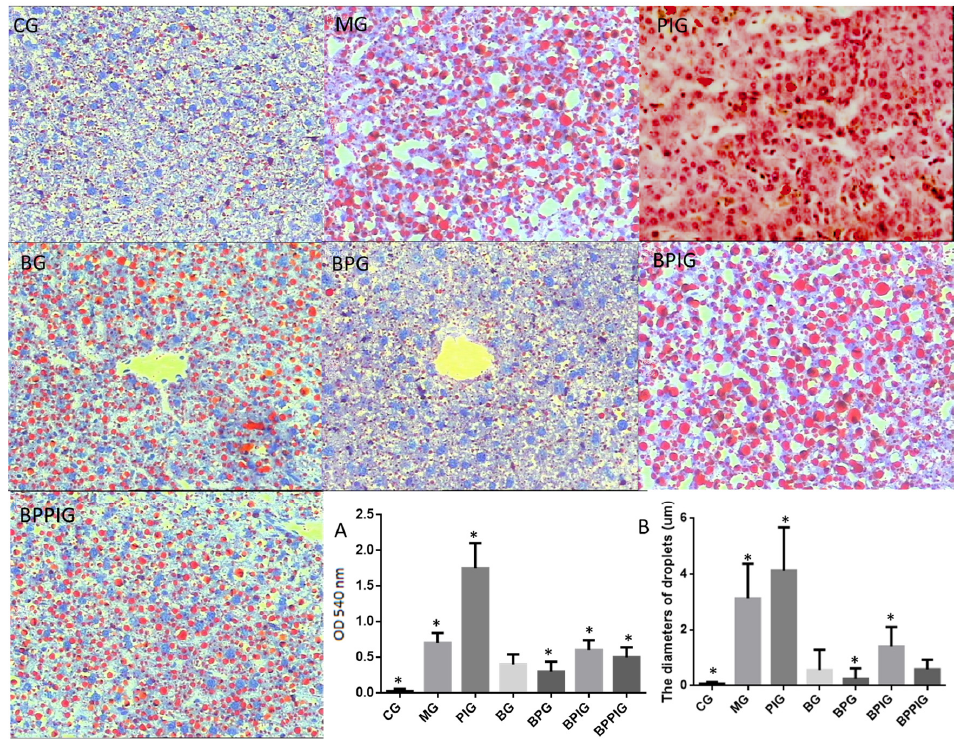
Figure 6. ORO analysis for the effects of BP on NASH and liver damage: ( A ) the absorbing value of the solvent of ORO extraction at 540 nm in different groups; and ( B ) the diameters of droplets in different groups. Eight liver samples were analyzed in each group. All data are presented as mean value ± S.D. * p < 0.05 via a blueberry juice group BG.